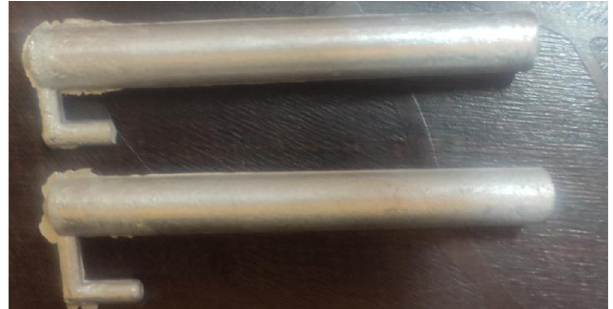
Fig. 3. Al2214-B 4 C composite after casting.